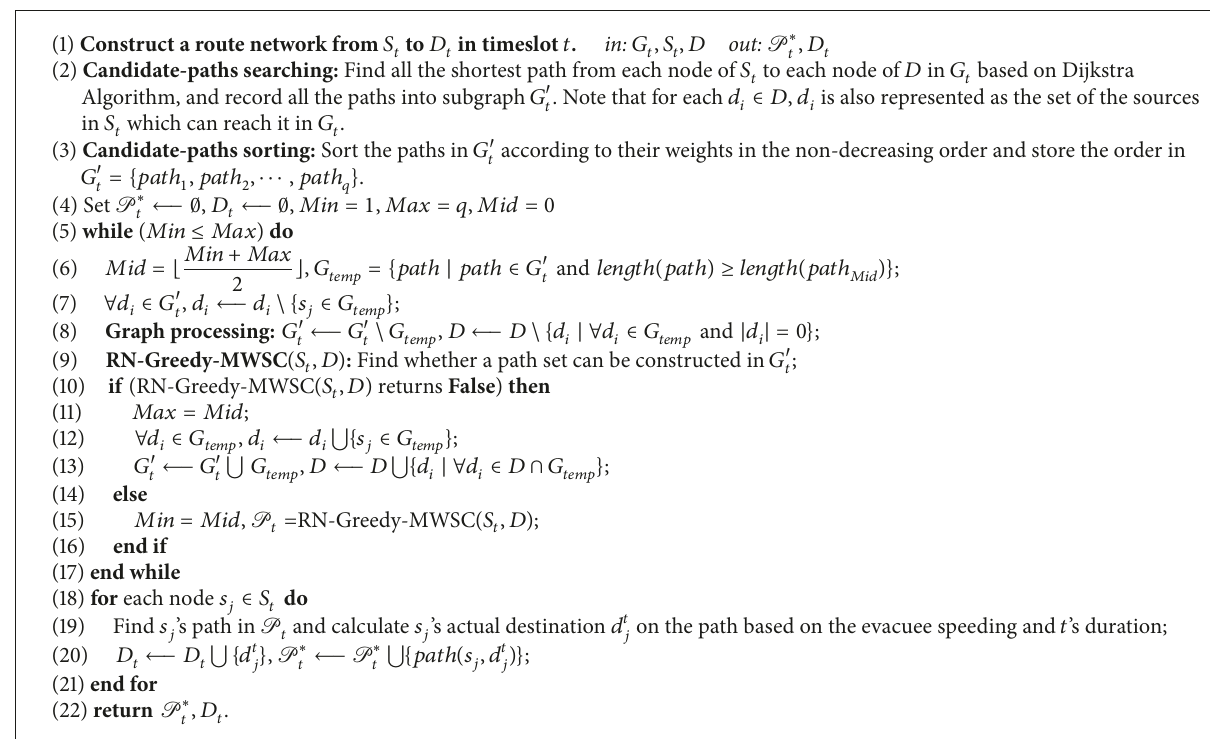
Algorithm 1: Route-Network Planning Algorithm.